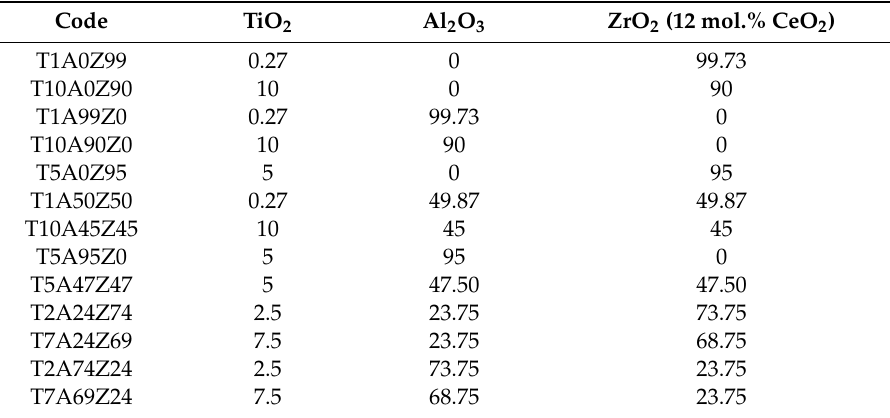
Table 1. Codes and details of components amount